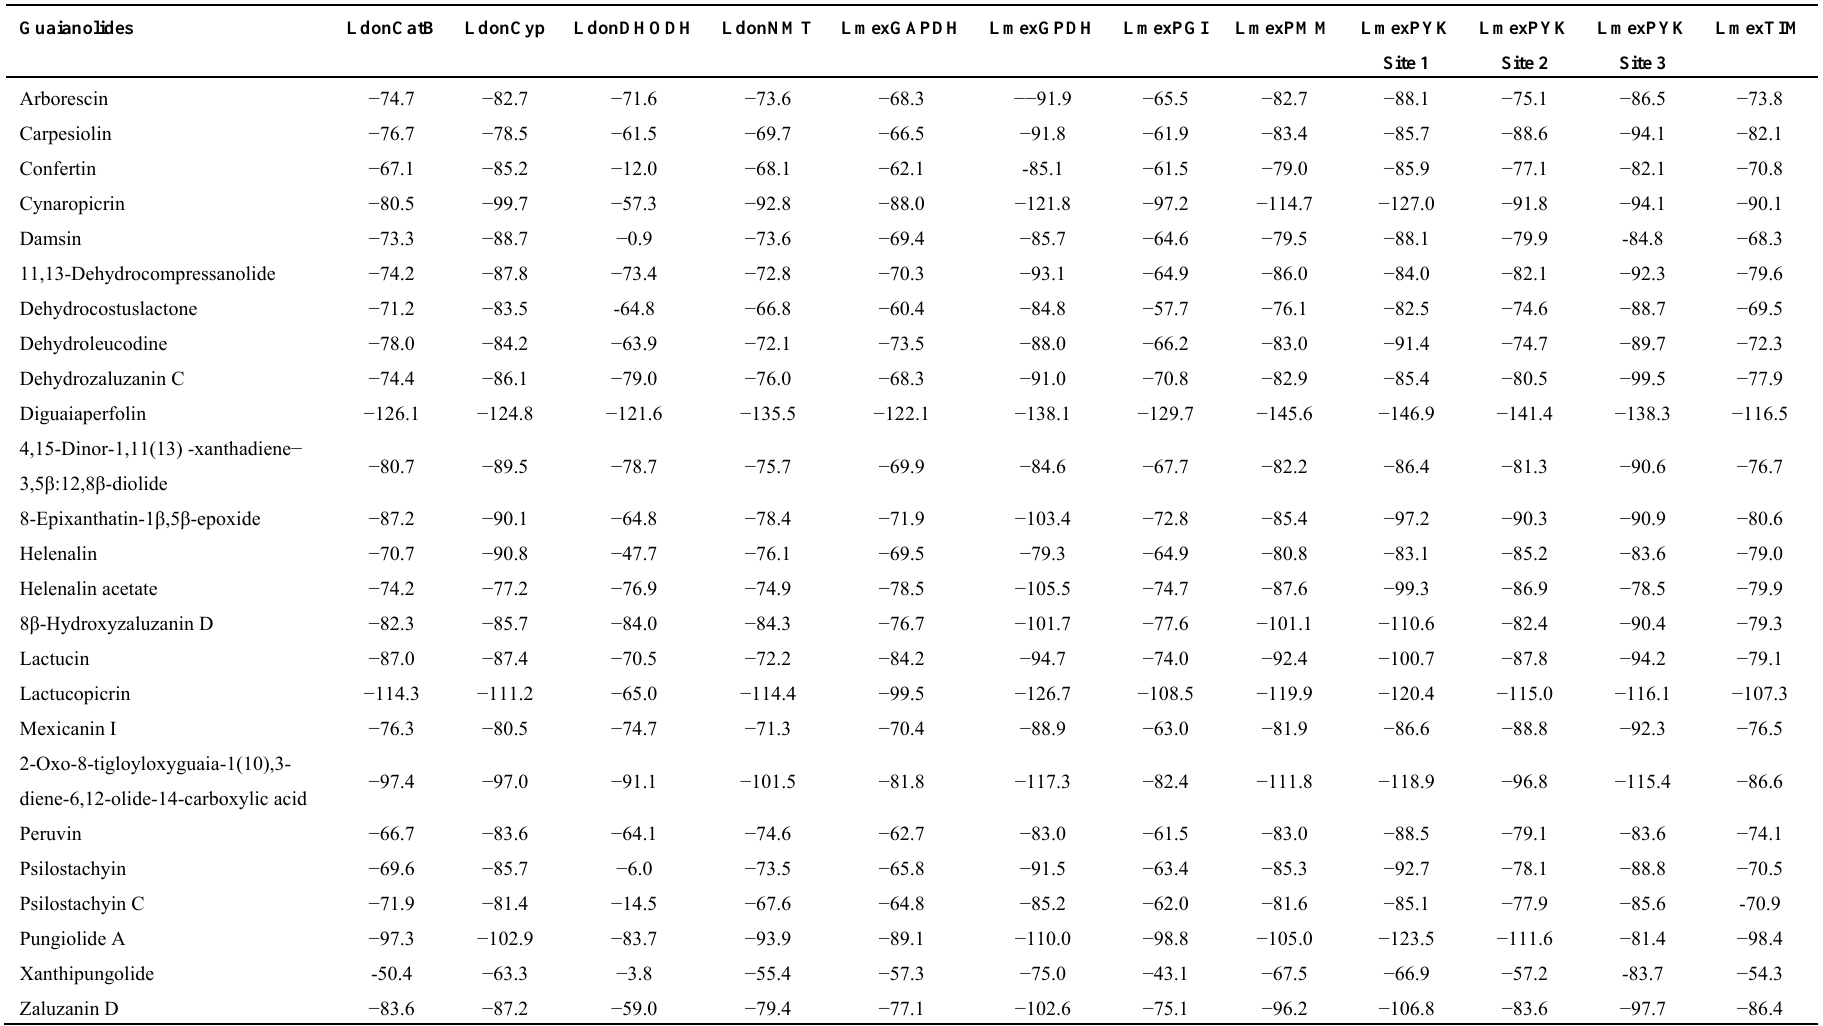
Table 8. MolDock docking energies (kJ/mol) of guaianolide sesquiterpenoids with Leishmania donovani and L. mexicana protein